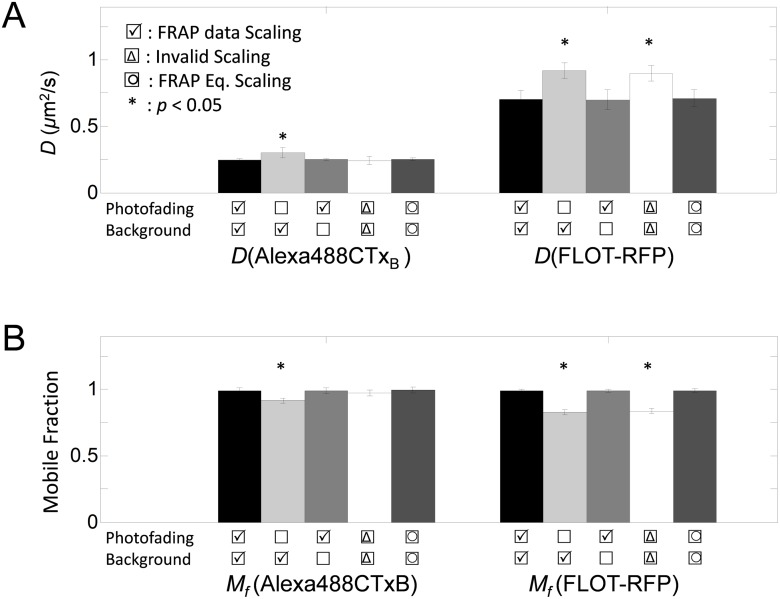
Best fitting diffusion coefficients (D) and mobile fractions (M
f) of Alexa488-CTxB and FLOT-RFP under different scaling scenarios.(A) and (B) show the best fitting diffusion coefficients (D), mobile fraction (M
f), and standard errors (N = 4 × 12 or N = 3 × 13). Statistically significant differences are denoted with asterisk (*).